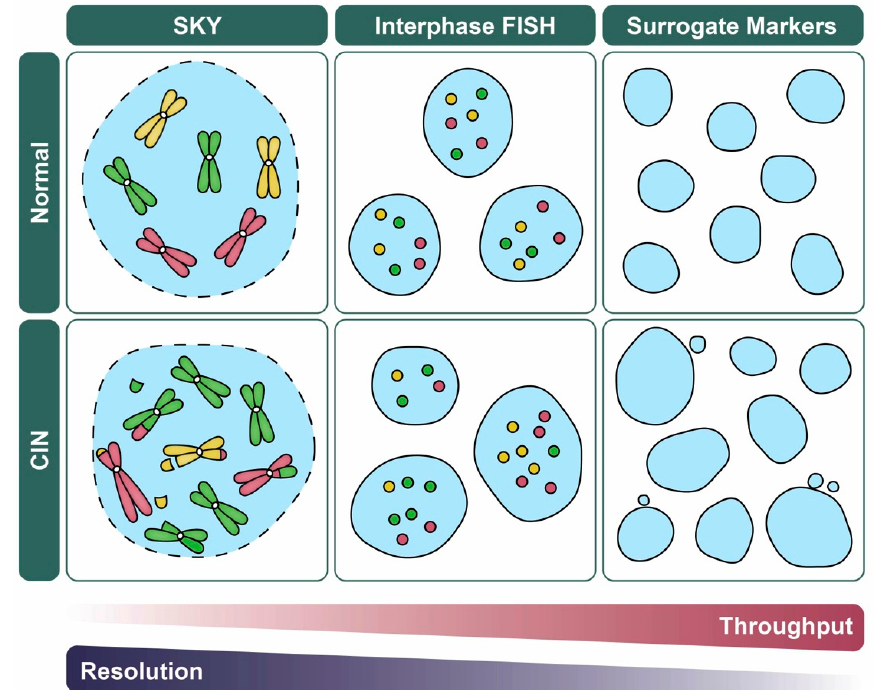
Figure 4. CIN-based analytics and the balance between data throughput and resolution. Schematic illustrating various quantitative imaging approaches used to assess CIN and their strengths in data throughput versus resolution (i.e., N- versus S-CIN). For illustrative purposes, representative examples of normal (top) and CIN-positive (bottom; N- and S-CIN) cellular contexts are shown. FISH (Section 4.2) and related approaches (e.g., fluorescent operator/reporter systems; Section 3.2) rely on enumeration of fluorescent foci rather than whole chromosomes which facilitates manual or automated analyses, but they do not detect N- or S-CIN involving other loci. Spectral karyotyping (SKY; Section 4.3) enables a genome-wide assessment of N- and S-CIN, but is not typically used to assess large sample sizes. Surrogate markers of CIN including changes in nuclear area and micronucleus formation (Section 5.1), are amenable to high-throughput approaches, but they do not specifically assess N- or S-CIN, and they may be subject to false positive/negative results.